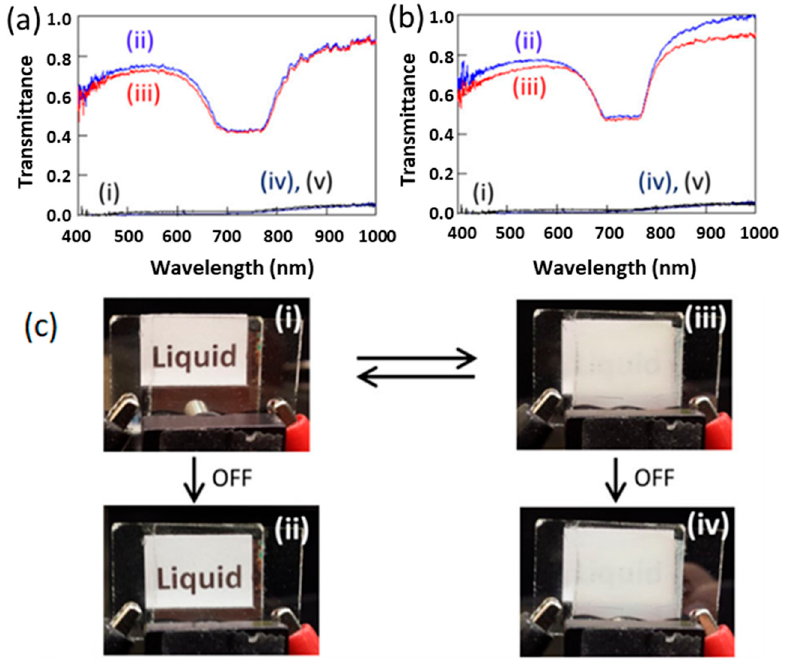
Figure 5. Bistable switching behavior of PSCLCs with ( a ) 30 µ m gap thickness: normal mode with (i) 0 V, (ii) 210 V DC, (iii) OFF (0 V), (iv) − 45 V DC, and (v) OFF (0 V), ( b ) (i) 0 V, (ii) 100 V AC, (iii)